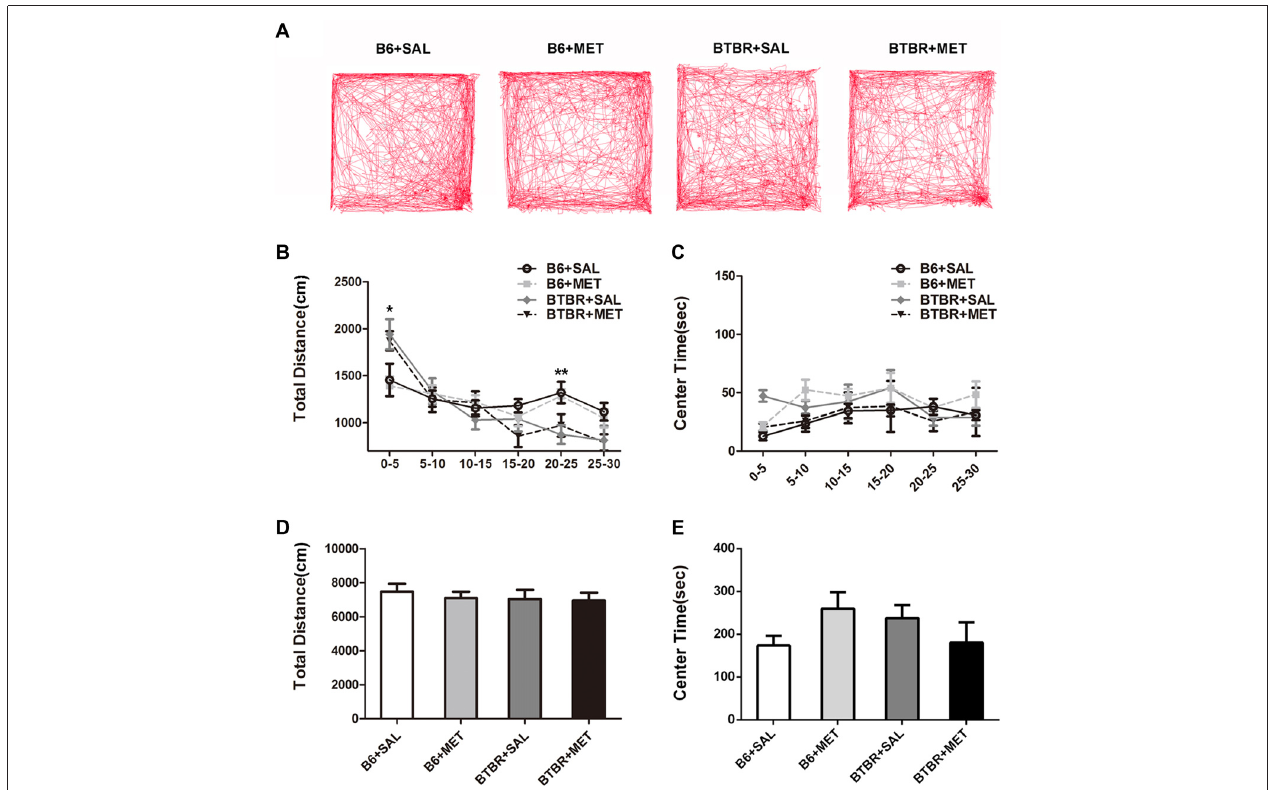
FIGURE 5 | Metformin treatment did not alter exploratory locomotion in the open field in B6 or BTBR mice. (A) The representative traces of different group mice in open field test show a 30-min assay of distance moved and time in center were computationally split into six segments with 5 min per segment. Compared with vehicle treated group, early metformin treatment did not have effects on distance traveled (B) and time spend in center (C) in each segment. Across the 30-min test, total distance traveled (D) and time in center (E) was not affected by early metformin treatment in B6 and BTBR mice. Data are presented as the means ± SEM. n = 10. ∗ p < 0.05, ∗∗ p <